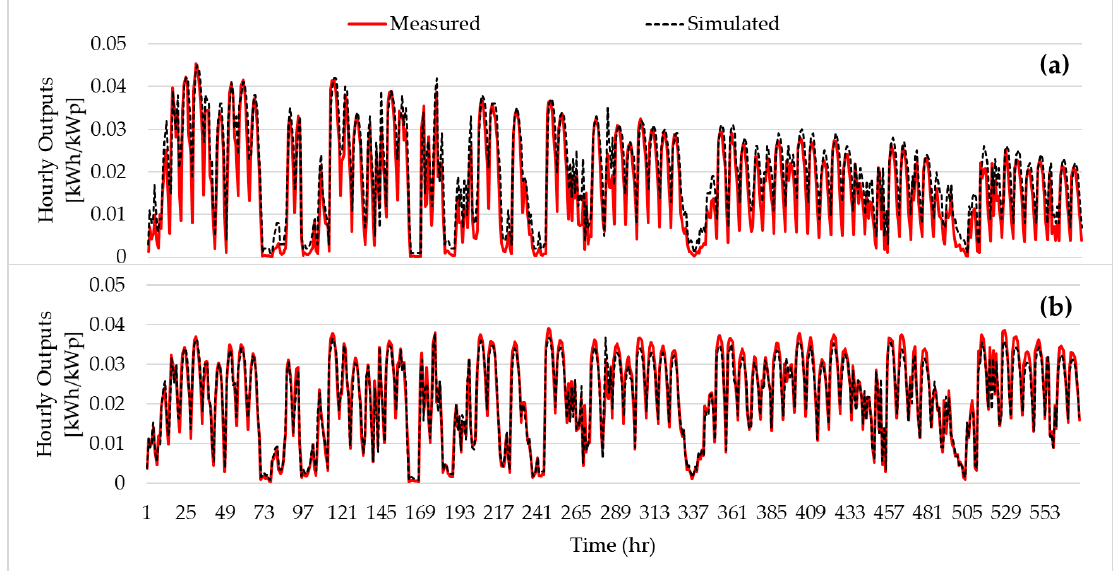
Figure 10. Comparison of hourly PV outputs between cracked measured and simulated data: ( a ) vertical and ( b ) inclined plane positions.